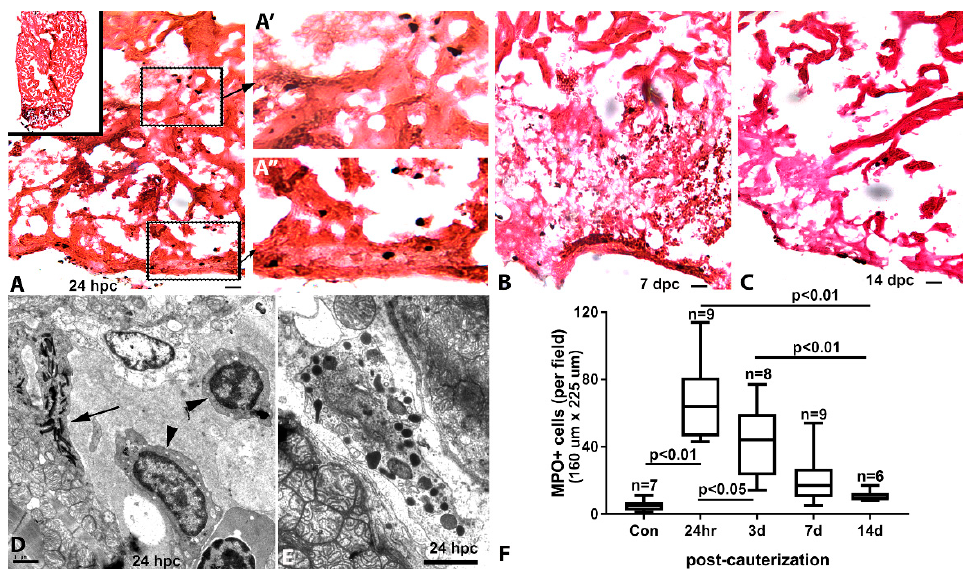
Figure 4. Inflammation in the cauterized zebrafish heart. ( A ) Myeloperoxidase (MPO)-reactive inflammatory cells (black) in a 24 h post-cautery (hpc) ventricle counterstained with eosin (orange). MPO reactivity is localized primarily in the injured region (inset). MPO-positive inflammatory cells in the cauterized apex shown at higher magnification in the spongy myocardium ( A’ ) and the compact and junctional region of the myocardium ( A” ). MPO-reactive cells in the necrotic apical region at ( B ) 7 days post-cautery (dpc) and ( C ) 14 dpc. ( D ) Transmission electron micrograph of inflammatory cells (arrowhead) in the lumen of the injury border zone and a heterophil attached to an adjacent cardiac myocyte (arrow). ( E ) A granule-filled inflammatory cell between two adjacent injured cardiac myocytes at 24 hpc. ( F ) Quantitation of MPO-positive cell infiltrate in the injured area over a 2-week period post-cauterization. Scale bars: A – C = 10 µm, D – E = 1 µm.